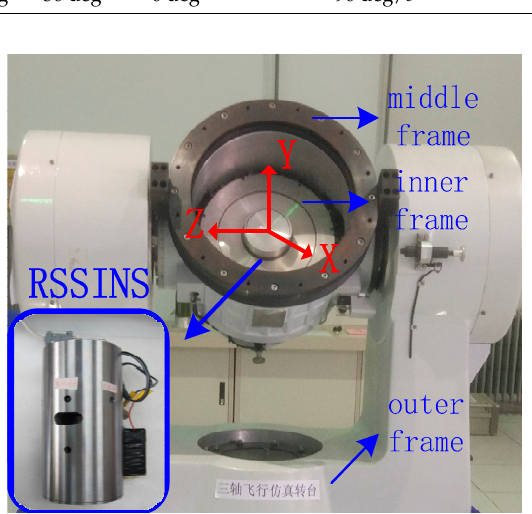
Figure 11. RSSINS installation on tri-axial rotation table.